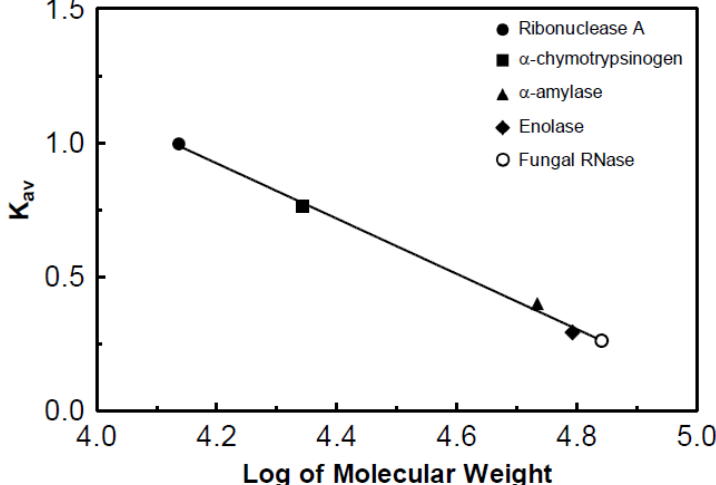
Figure 10. Molecular weight determination of the partially purified RNase. Molecular weights of protein standards were: ribonuclease A, 13,700; α -chymotypsinogen, 25,000; α -amylase, 51,000; and enolase, 82,000. The log molecular weight of the RNase was determined to be 4.841, which is roughly equal to a molecular weight of 69 kDa.